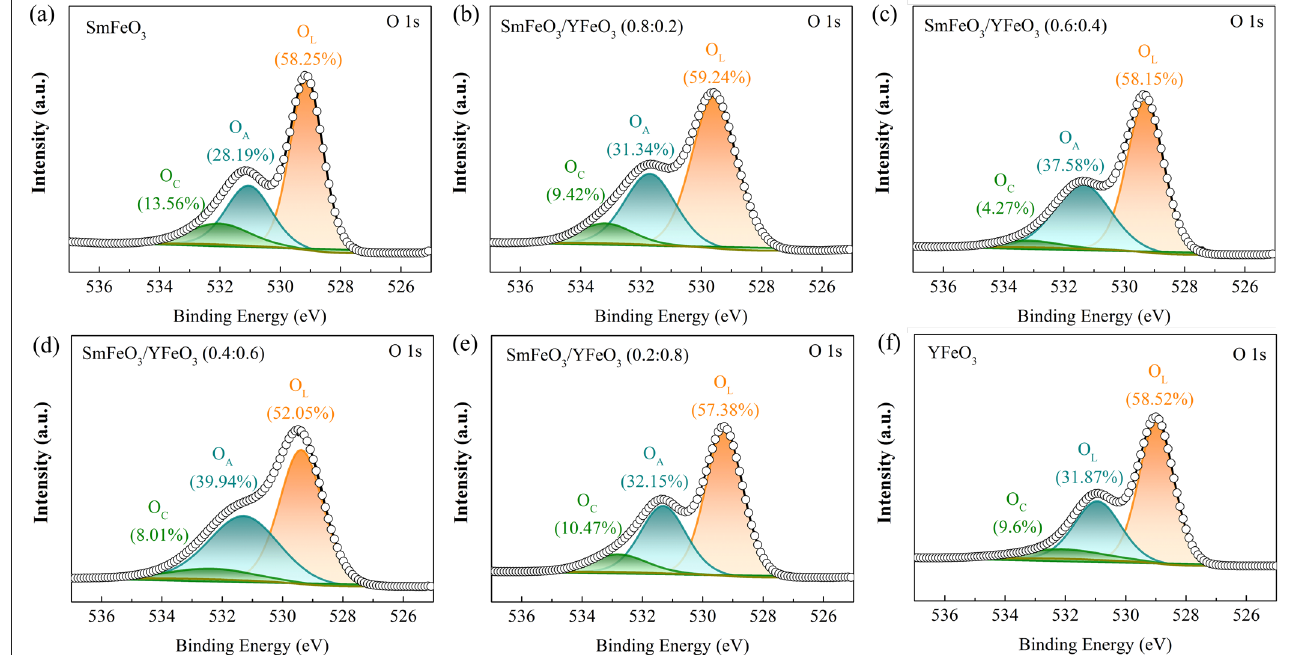
Figure 4. High-resolution XPS spectra of O 1s in SmFeO 3 /YFeO 3 nanomaterials: ( a ) SmFeO 3 , ( b ) 0.8:0.2, ( c ) 0.6:0.4, ( d ) 0.4:0.6, ( e ) 0.2:0.8, and ( f ) YFeO 3 .